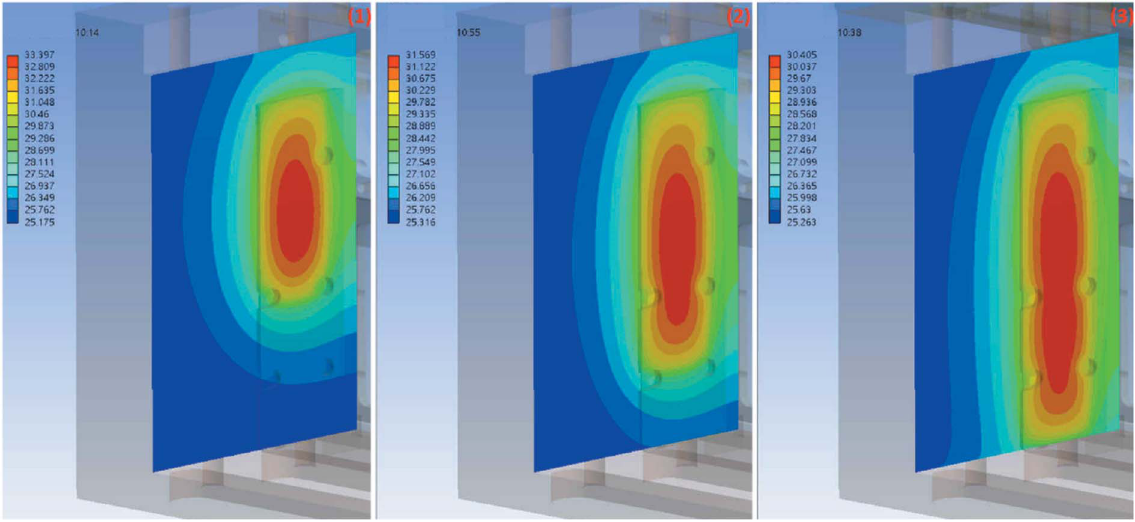
Figure 16 Numerical simulation results with for temperature distribution of the chamber wall contact area, (1) contact ratio 60%, (2) contact ratio 80% and (3) contact ratio 100%.